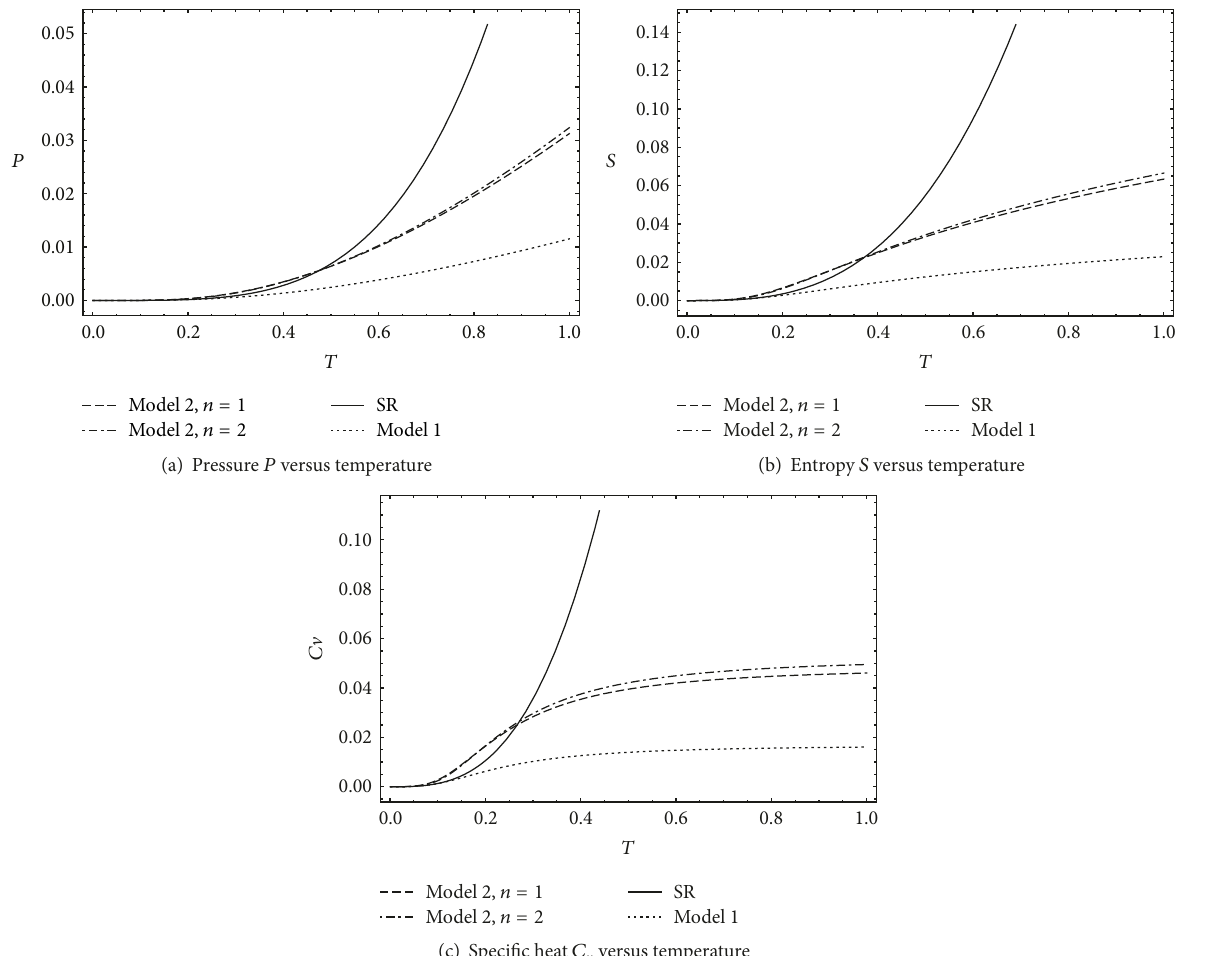
Figure 1: In this figure, we have plotted pressure 𝑃 , entropy 𝑆 , and specific heat 𝐶 V of photon gas against temperature 𝑇 for model 1 (DSR) and model 2 with 𝑛 = 1 and 𝑛 = 2 . The results of models 1 and 2 have been obtained numerically using 𝑀𝑎𝑡ℎ𝑒𝑚𝑎𝑡𝑖𝑐𝑎 . We also used the Planck units, and the corresponding parameters take the following values: 𝐸 𝑃 = 1 , 𝑘 𝐵 = 1 , 𝑉 = 1 , ℎ = 1 , and 𝑐 = 1 . In this scale, 𝑇 = 1 is the Planck temperature, 𝑇 𝑃